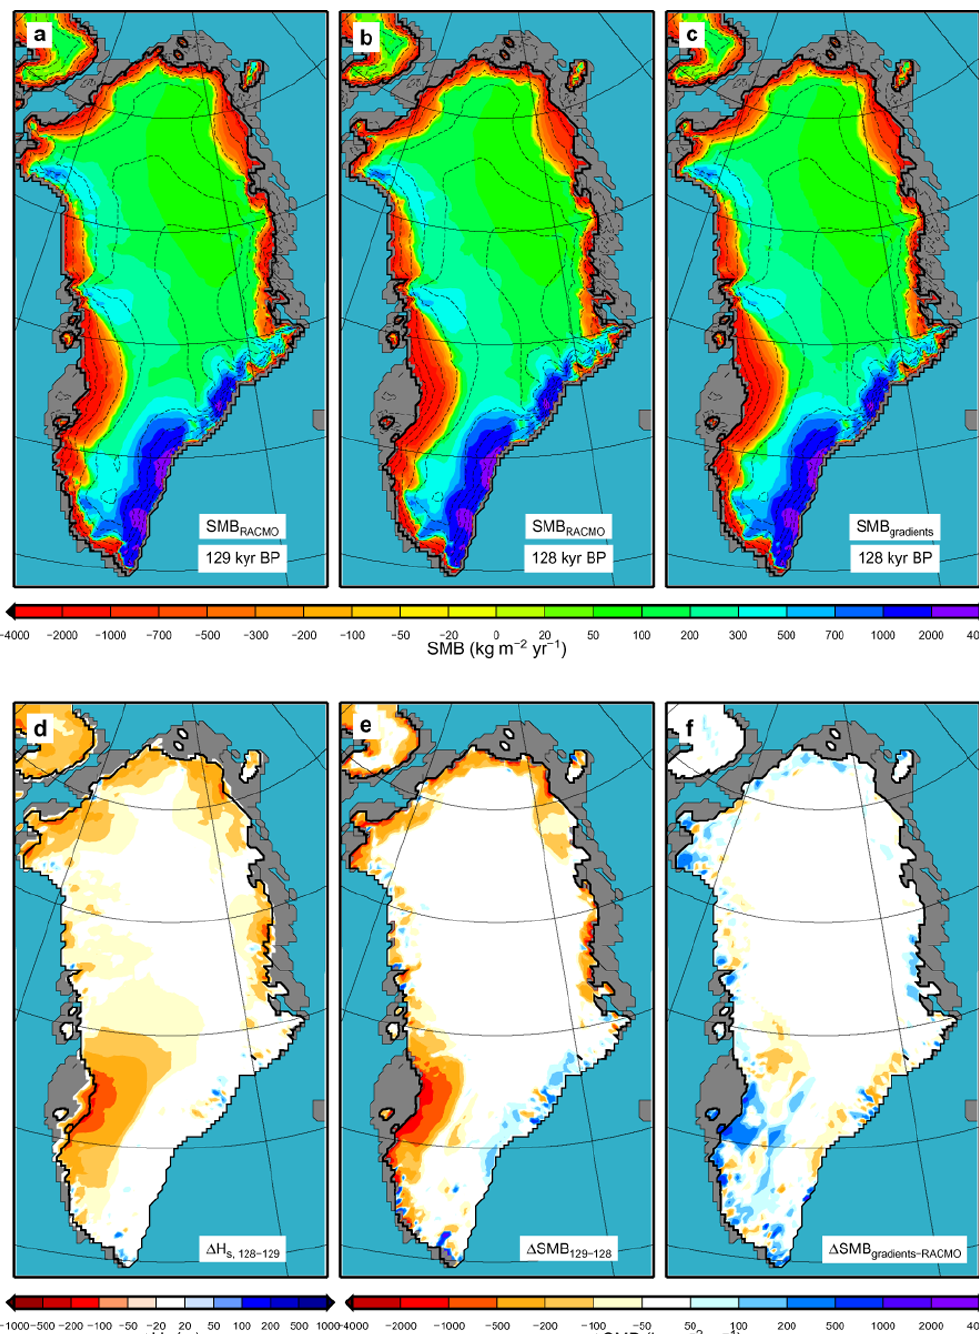
Fig. 15. SMB gradients evaluation: (a , b) two different ice sheet geometries (dashed lines show 500m contourlines) and SMB patterns (colors) as calculated by RACMO2/GR using Eemian maximum insolation as boundary conditions for 129 and 128kyrBP; (c) predicted SMB pattern for the ice sheet elevation at 128kyr using SMB gradients based on the RACMO2/GR SMB pattern at 129kyrBP from (a) ; (d) differences in H s ; (e) differences in SMB RACMO ; (f) differences between SMB gradients and SMB RACMO at 128kyrBP.